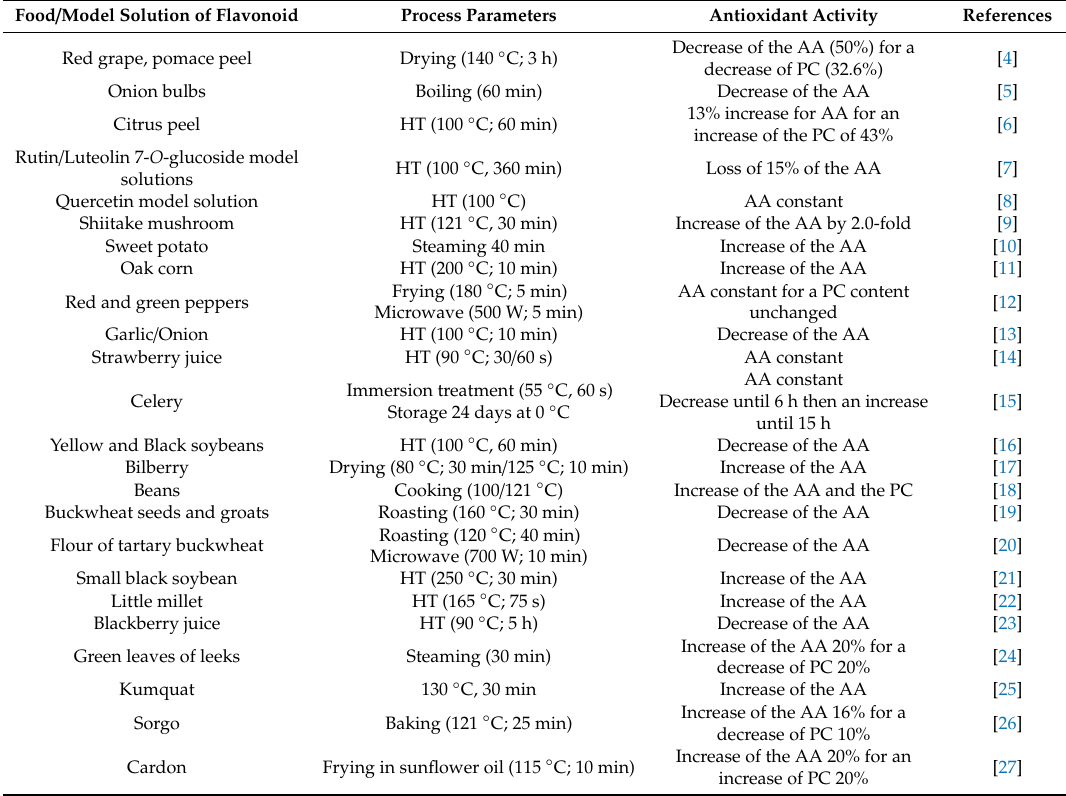
Figure 1. The main chemical features responsible for antioxidant activity. Table 1. Review on the studies dealing with the evolution of antioxidant activity (AA) of phenolic compounds (PC) during a heat treatment